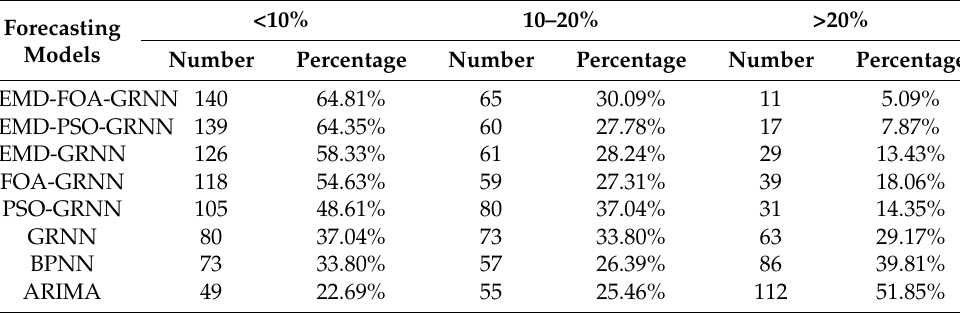
Figure 12. The absolute value of error by the EMD-FOA-GRNN model. Table 3. Accuracy estimation of forecasting models for the test samples.